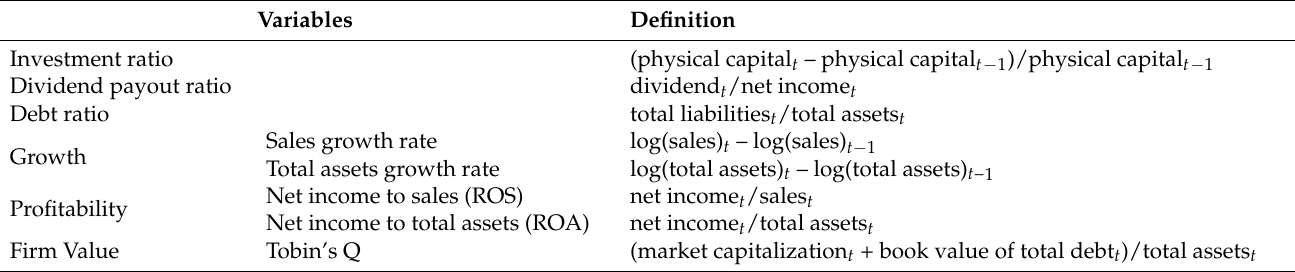
Table 1. Definition of key accounting